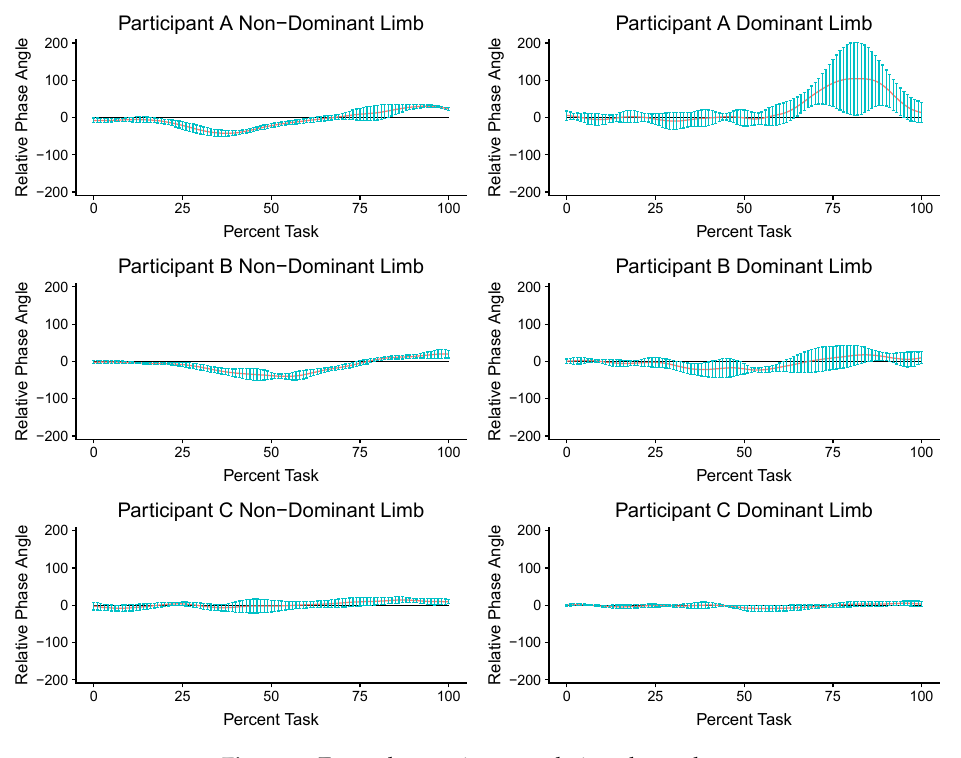
Figure 1. Exemplar continuous relative phase plots.